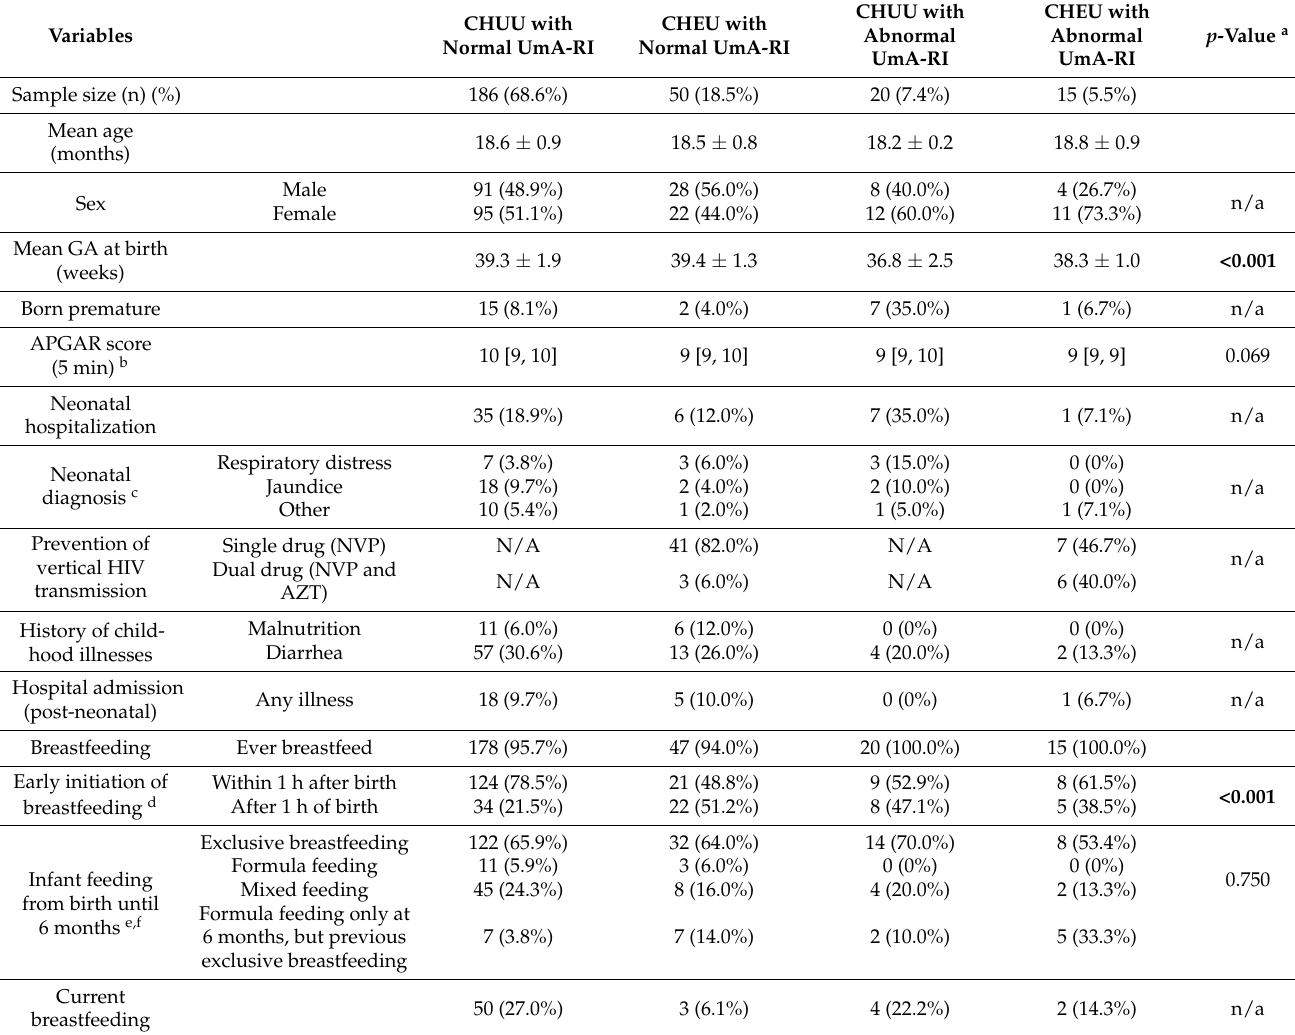
Table 2. The medical background of children from birth to age 18